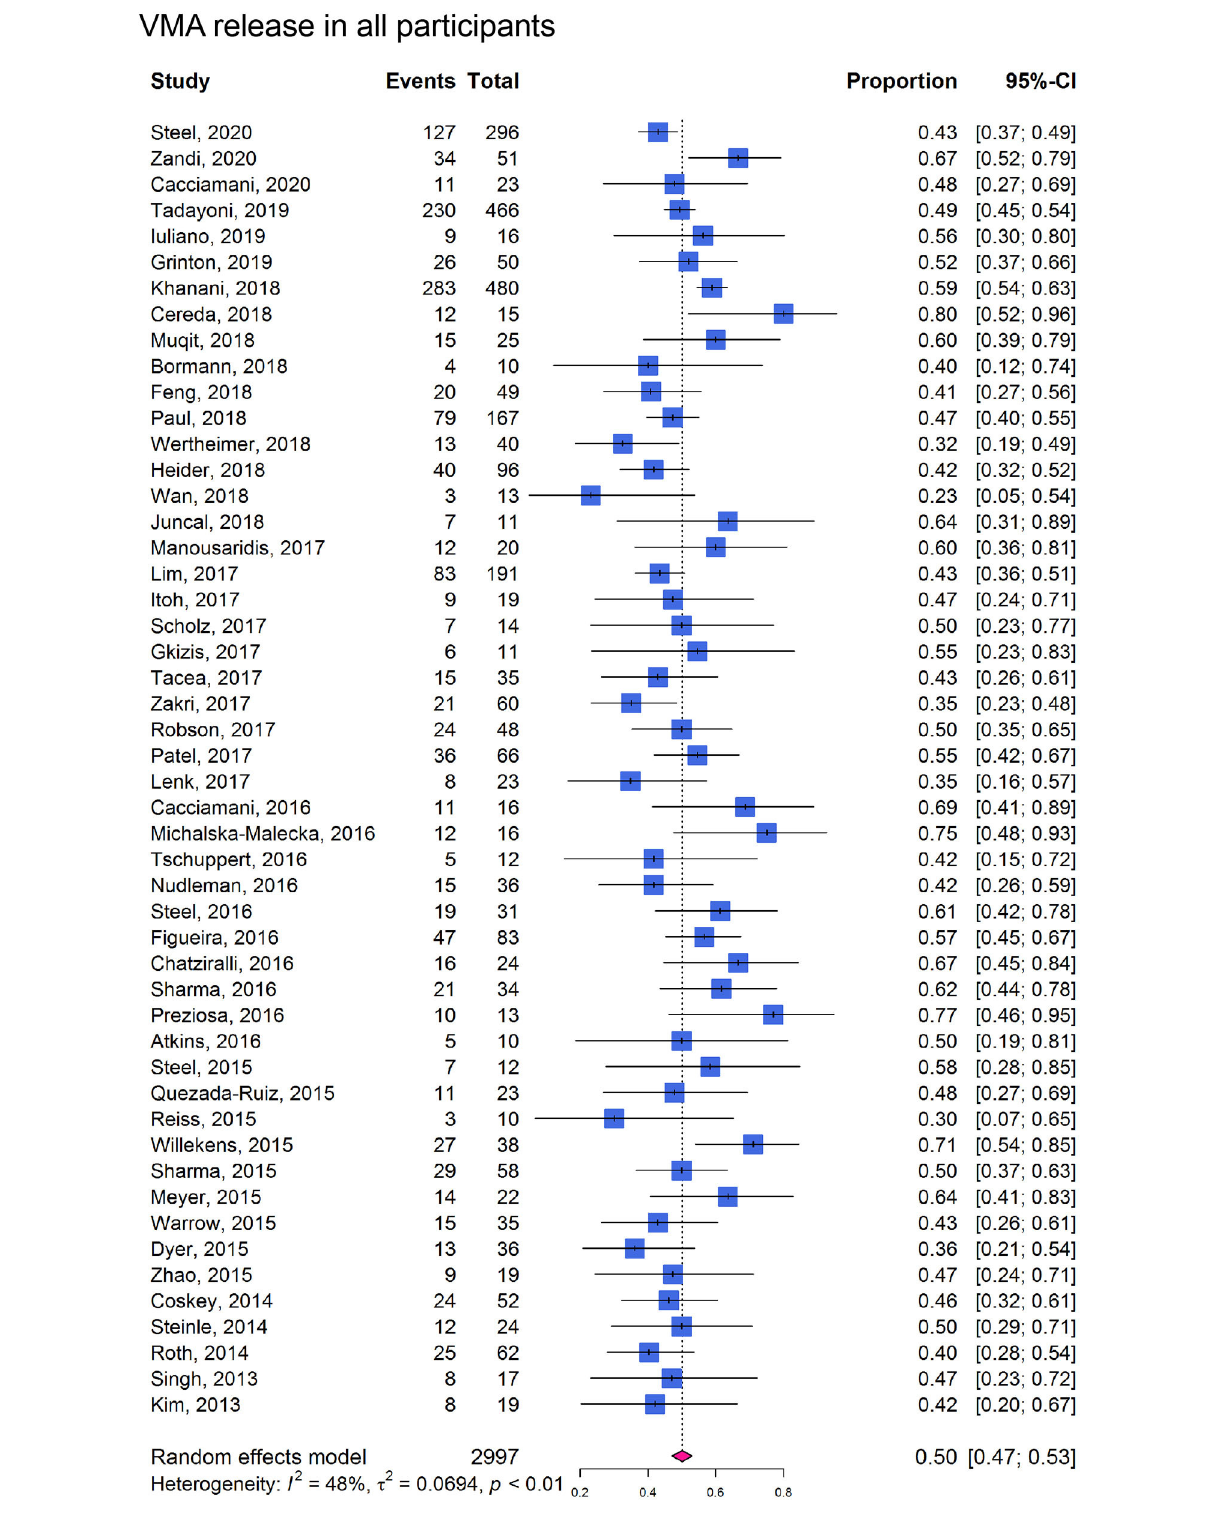
Frontiers in Medicine |